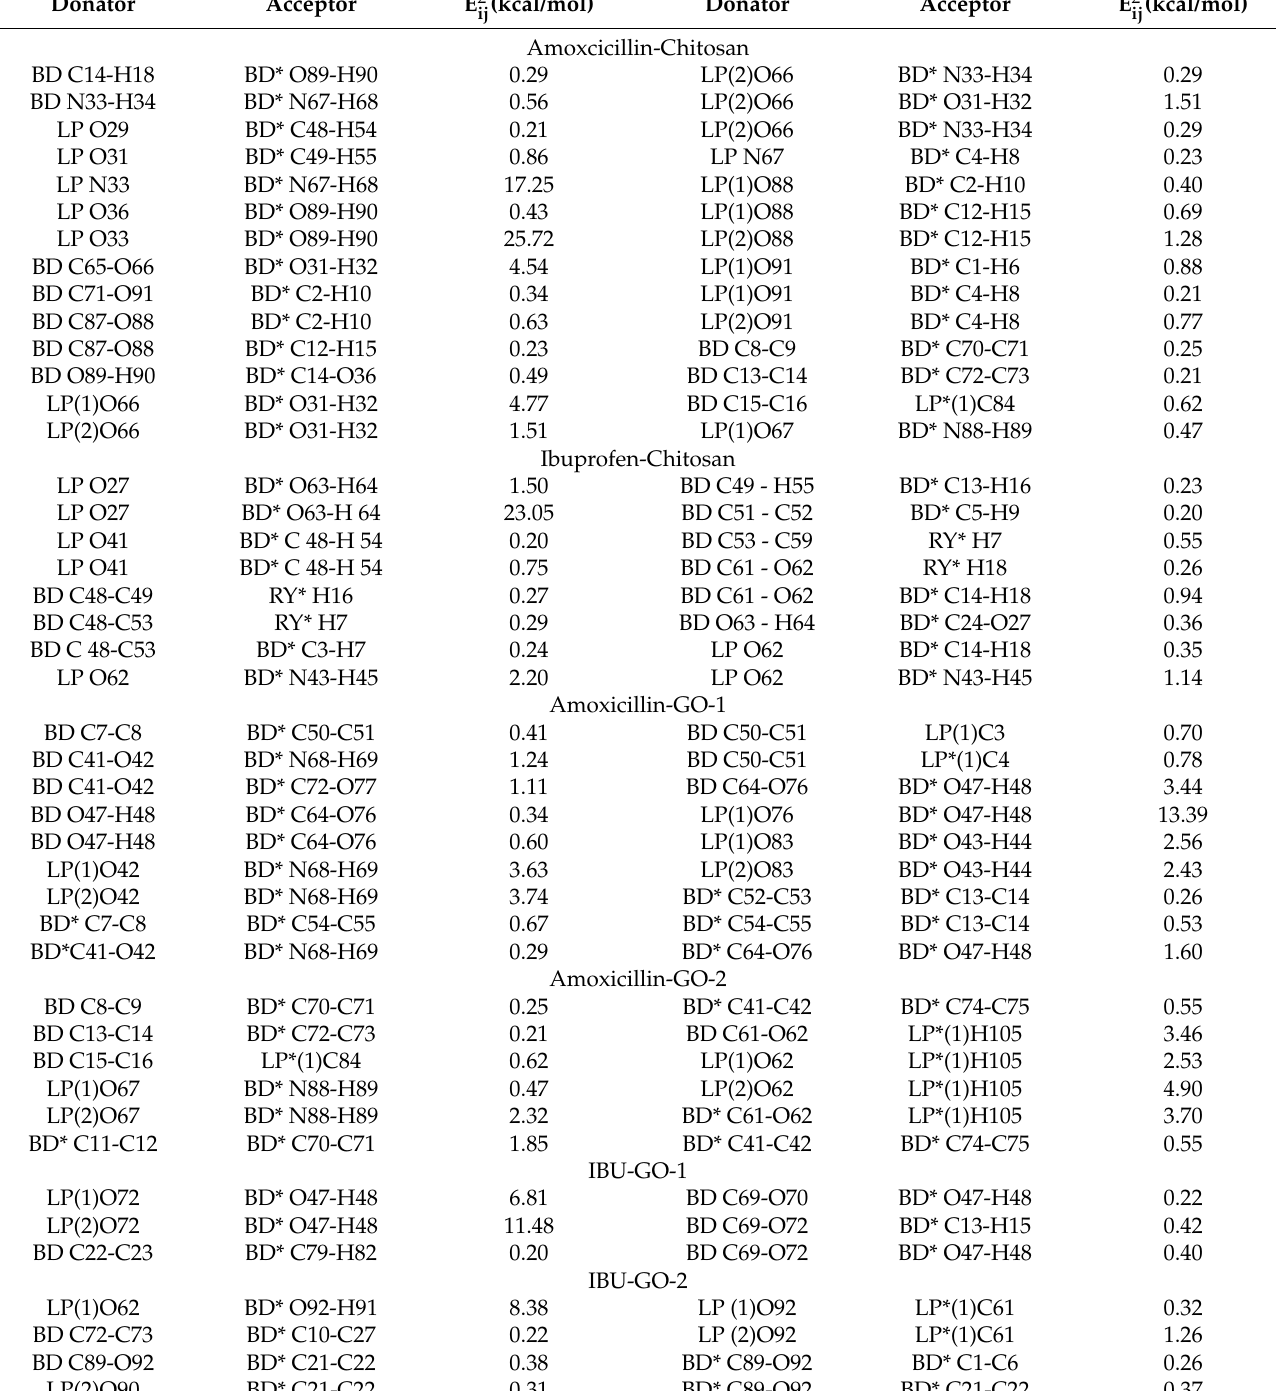
Table 3. The second-order perturbation theory for amoxicillin and ibuprofen with chitosan and graphene-oxides dimers, by using Fock matrix from Natural Bond Orbital (NBO) calculation at the ω B97X-D/6-31G++(d,p) theory